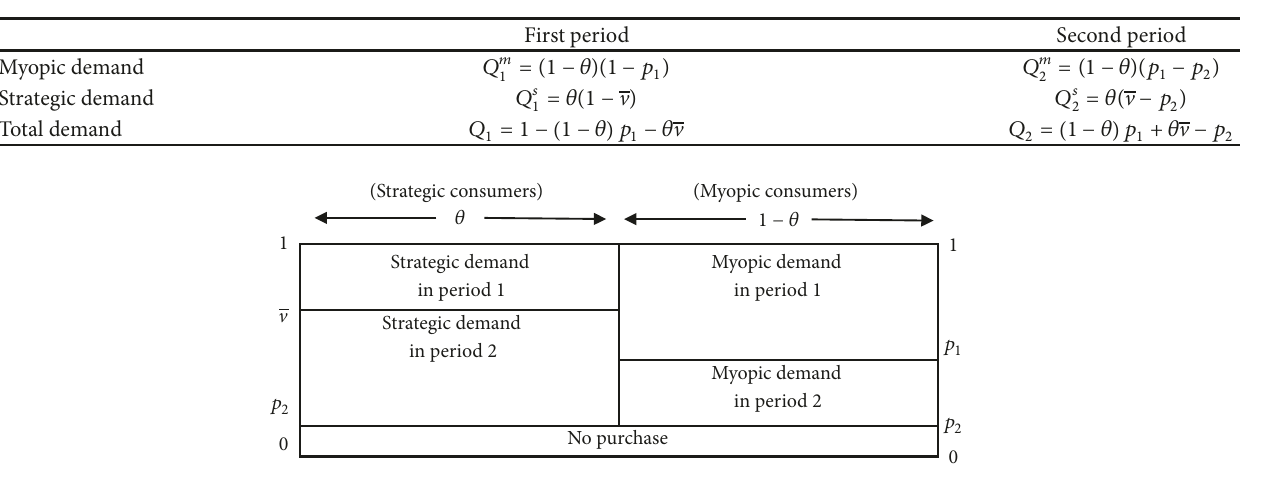
Figure 1: Customer segmentation between strategic and myopic